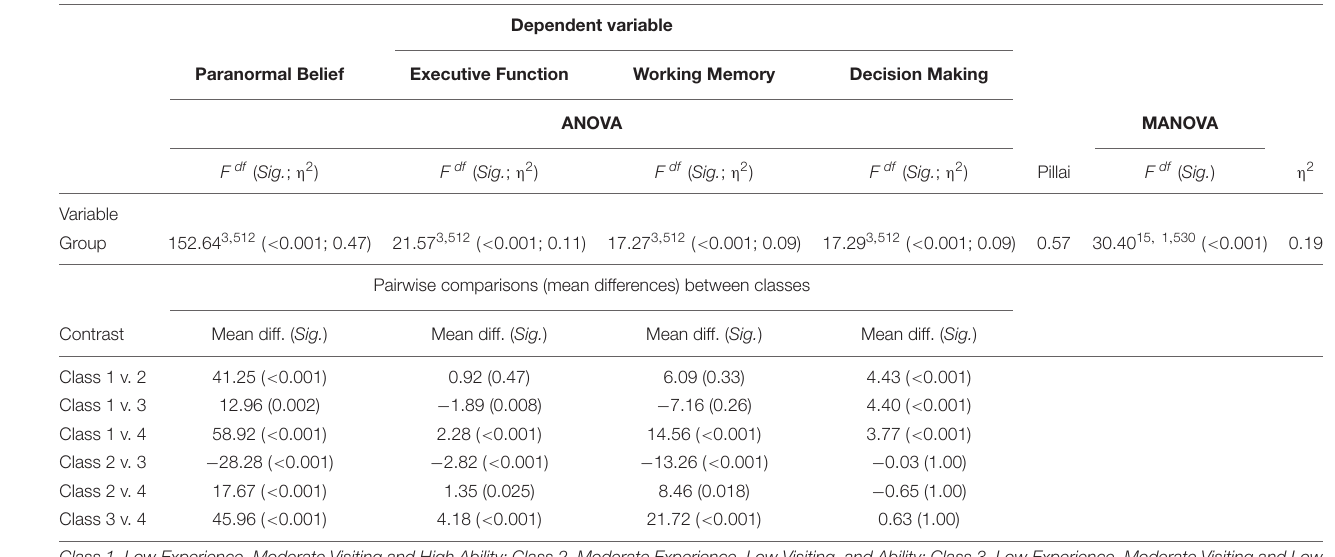
FIGURE 1 | Latent profiles in relation to Paranormal Experience, Paranormal Practitioner Visiting, and Paranormal Ability (scores range from 0 to 1 since they are depicted as probabilities/percentages). TABLE 3 | Latent profile effects on paranormal belief, executive function, working memory, and decision